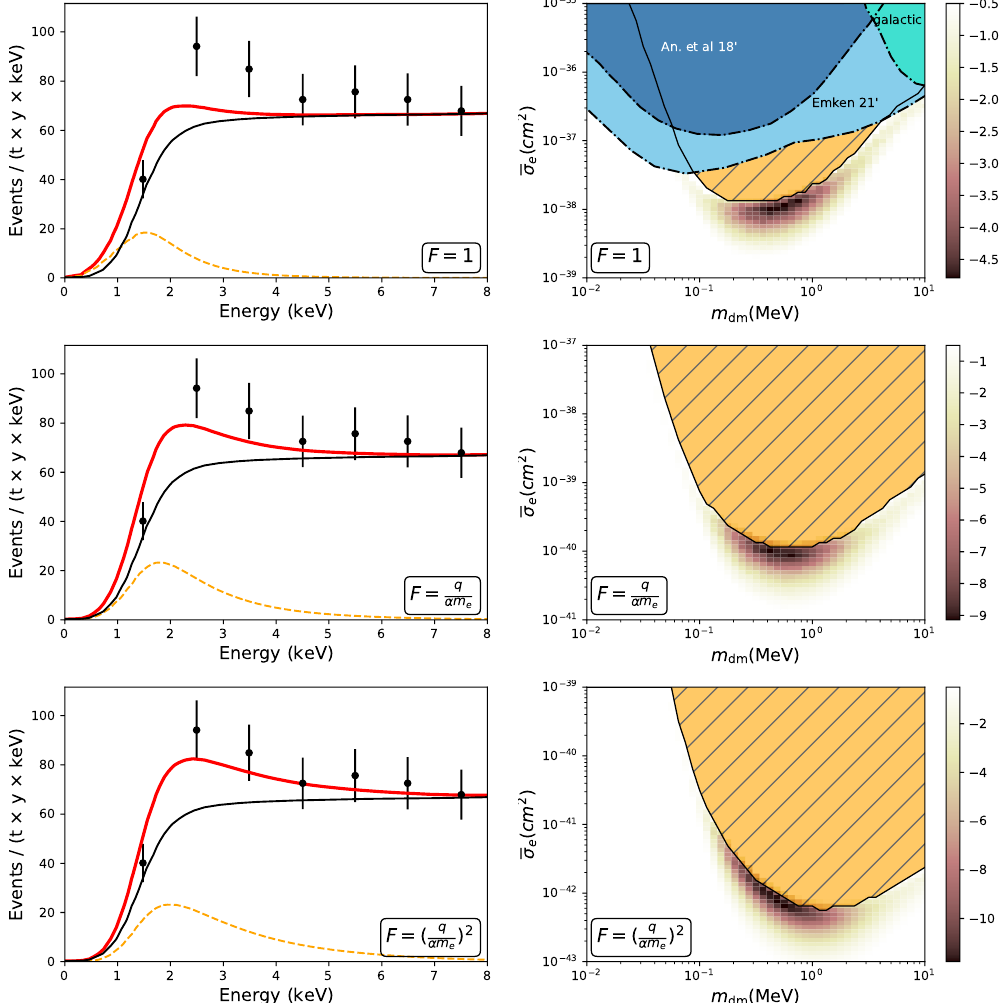
Figure 2 . Left: best-fit results to the XENON1T data when the Sun-heated DM-induced electron recoils are included, for F ( q ) = 1 (top), q (middle), and ( q ) 2 (bottom), respectively. See αm e αm e the text for the best-fit model parameters. Right: 95% exclusion regions (hatched orange areas) on the m dm − ¯ σ e plane from the XENON1T 2020 data. For the F ( q ) = 1 case, previous limits from ref. [23] considering the Sun-heated DM scenario and the recent bounds from low-threshold SENSEI experiment [33] are also shown for comparison, as well as a bound based on the S2-only analysis [34,